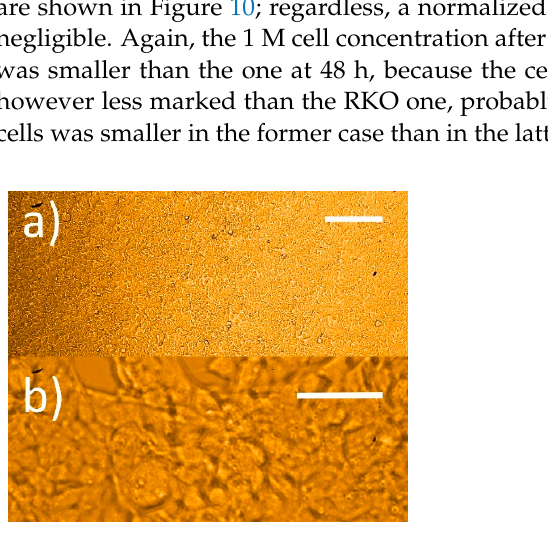
Figure 11. Microphotograph of confluent HEK-293. ( a ) Cells withdrawn from the incubator at 72 h initially plated at 1 M cells/dish, scale bar is 200 µ m; ( b ) cells in a) at higher magnification, scale bar is 50 µ